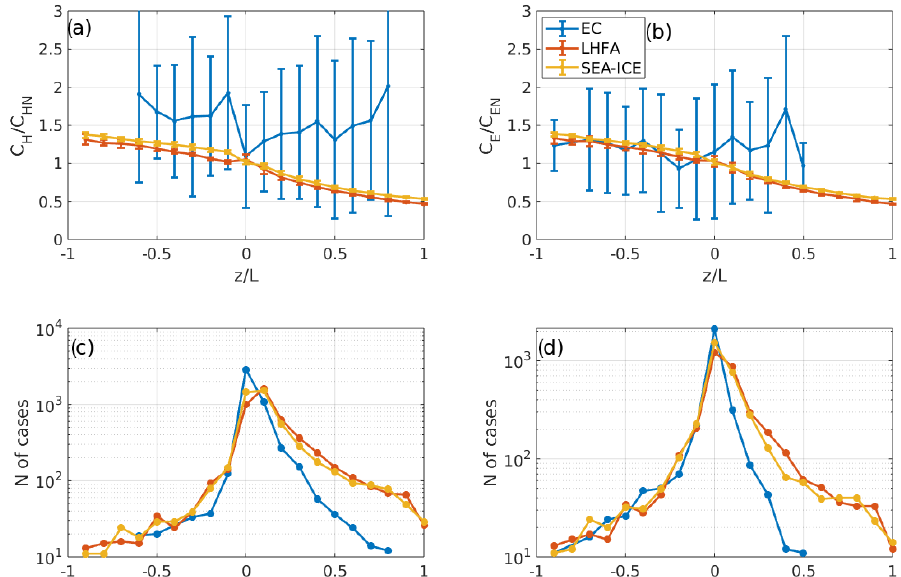
Figure 12. Normalized and binned values of transfer coefficients as a function of the stability parameter for C H (a) and C E (b) . C H data were filtered for small temperature differences ( | T 0 − T a | < 0 . 5K) and C E data were filtered for very small and negative values of the humidity difference ( q 0 − q a < 2 × 10 − 4 kgkg − 1 ). The 30min values of coefficients were also not included in case of very low wind speed ( U < 0 . 5ms − 1 ). Bins were rejected if they had fewer than 10 values within them. Panels (c) and (d) correspondingly present the distribution of transfer coefficient values as a function of the stability